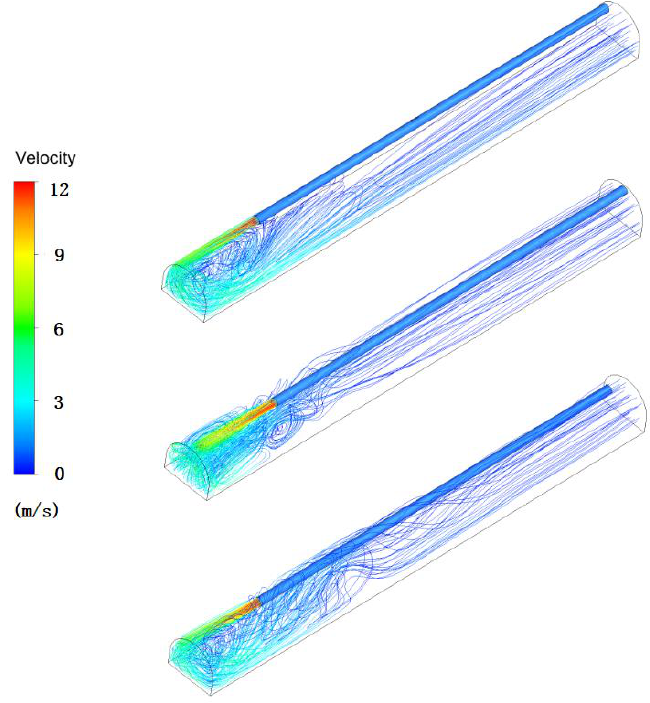
Figure 11. Speed streamline distribution of Models 1–3.